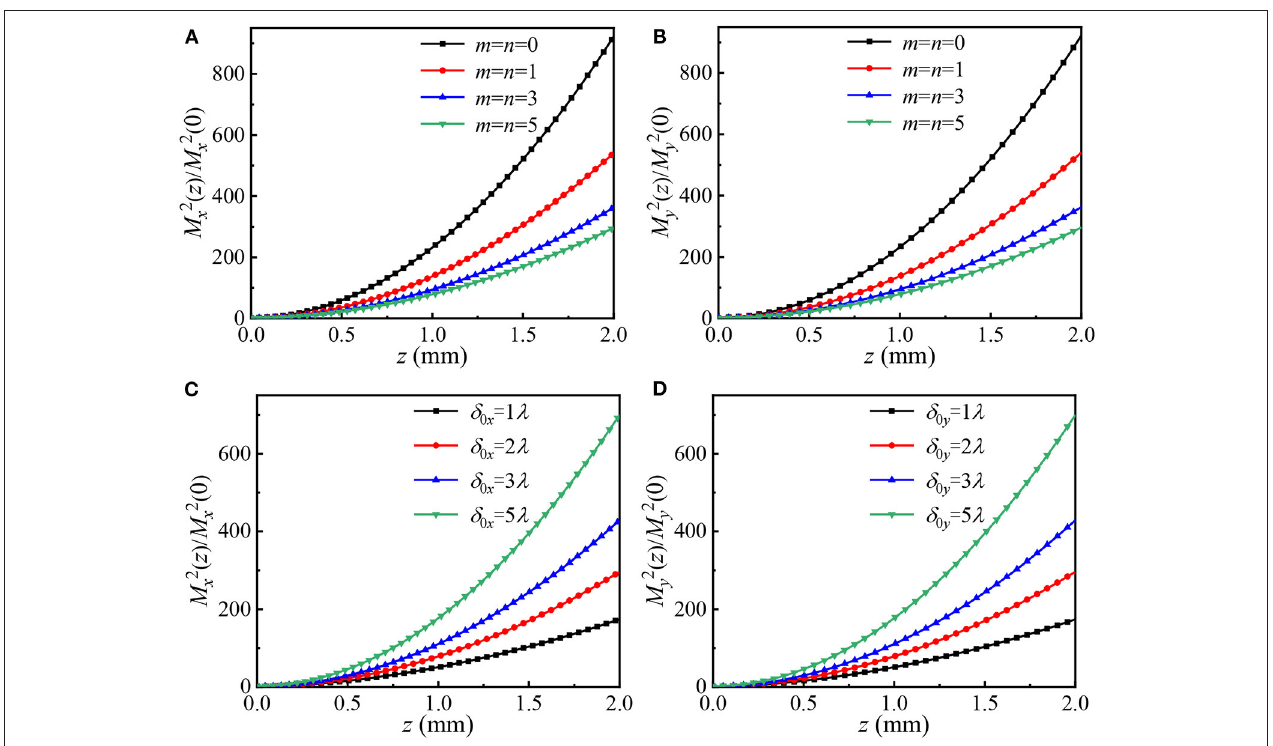
FIGURE 5 | Normalized propagation factors of HGCSM beams vs. propagation distance in turbulent biological tissue for different values of the mode orders m , n , and the transverse coherence width. (A,C) along x direction, (B,D) along y direction. width. The calculation parameters are m n 0, 1, 3, 5 in = = Figures 5A,B , δ 0 x or δ 0 y 1 λ , 2 λ , 3 λ , 5 λ in Figures 5C,D , and = other parameters used in the simulation are the same as Figure 3